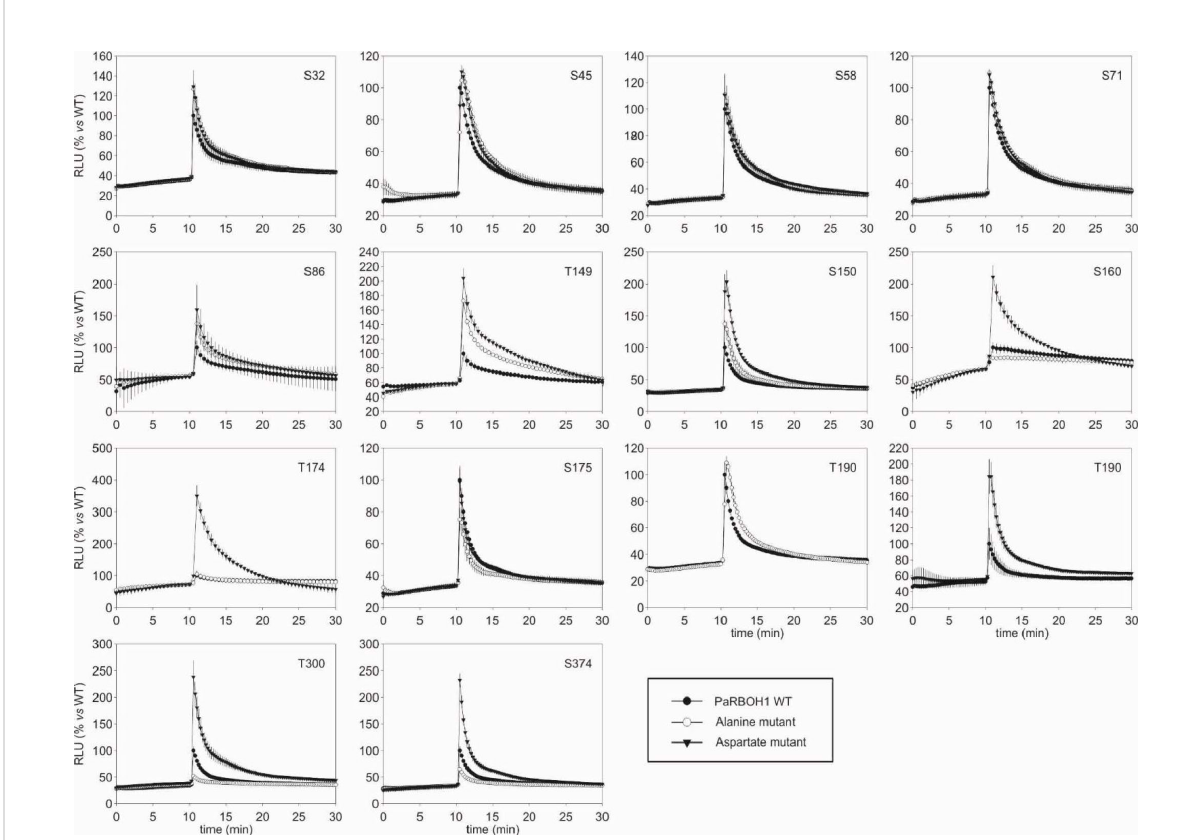
FIGURE 4 Impact of alanine (A) and aspartate (D) phosphosite substitution mutants of PaRBOH1 on ionomycin-induced ROS production in transfected HEK293T cells. ROS production was detected by luminol-ampli fi ed chemiluminescence. HEK cells were transiently transfected with PaRBOH1 WT (wild type), PaRBOH1 with serine/threonine-alanine mutation (A, kinase-inactive) or PaRBOH1 with serine/threonine-aspartate mutation (D, phosphomimic) at the indicated PaRBOH1 phosphotarget site. ROS production activity of PaRBOH1 and its A and D mutants was measured in response to adding 1 µM ionomycin and 1 mM Ca 2+ at 10 min and expressed as relative luminescence units (RLU; PaRBOH1 WT response was set to 100%). Results are means of three wells ± S.E. (n = 3). Similar results were obtained at least in three independent